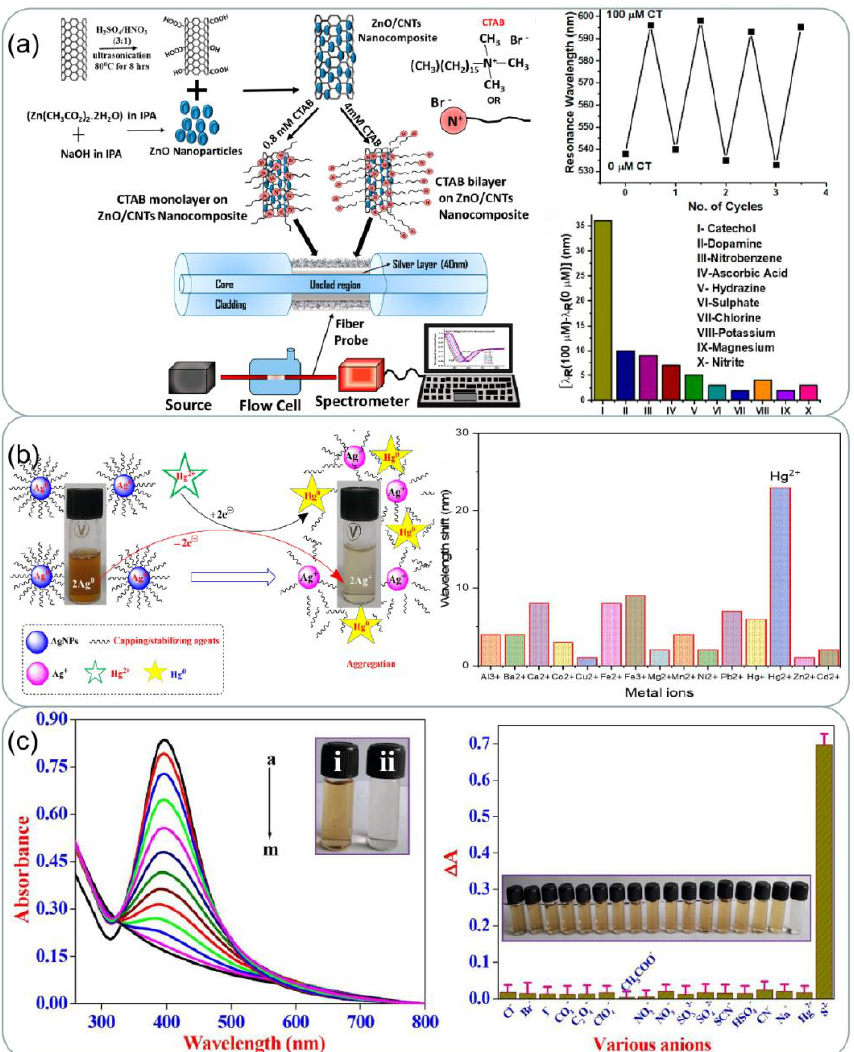
Figure 10. ( a ) Schematic of synthesis of functionalized CNTs and ZnO nanoparticles, attachment of ZnO nanoparticles to CNTs walls, CTAB functionalization of ZnO/CNTs nanocomposite for two concentrations, fiber probe, and experimental set-up. Results of repeatability and selectivity for the finalized. Reprinted with permission from Ref. [122]. Copyright 2020, ACS Applied Nano Materials. ( b ) Schematic illustration of sensing of Hg 2+ by AV-AgNPs. UV-vis spectra recorded upon 1 mL addition of AV-AgNPs with different metal ion solutions (500 µ M, 2 mL). Reprinted with permission from Ref. [123]. Copyright 2022, Journal of Molecular Liquids. ( c ) SPR band changes of Cys-AgNPs with different amounts of S 2 − ion and inset shows photographic image of (i) Cys-AgNPs in the (ii) final addition S 2 − ions. Relative absorption intensities and the colorimetric response of Cys-AgNPs towards S 2 − ions as well 100-fold higher concentrations of different interfering